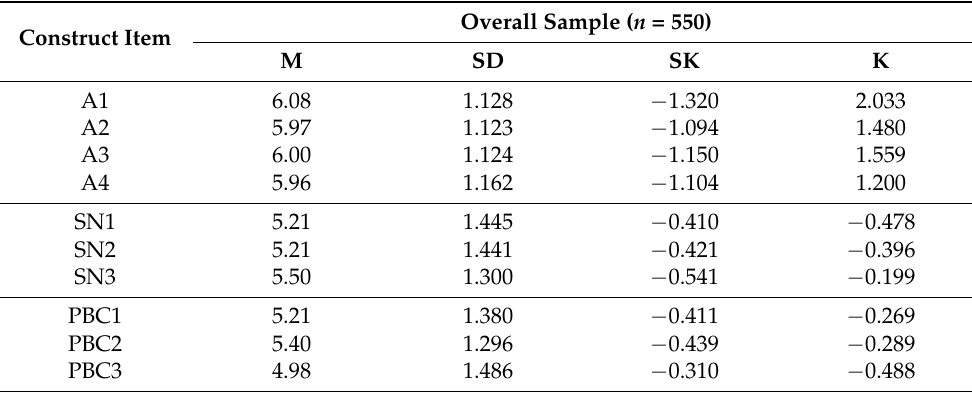
Table 4. Descriptive statistics of construct